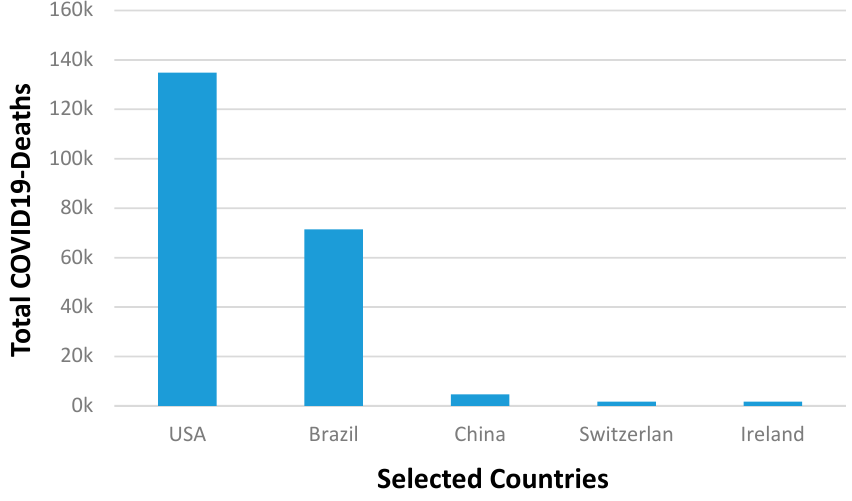
Figure 8. Total deaths due to COVID-19 infections in the selected countries of the world.